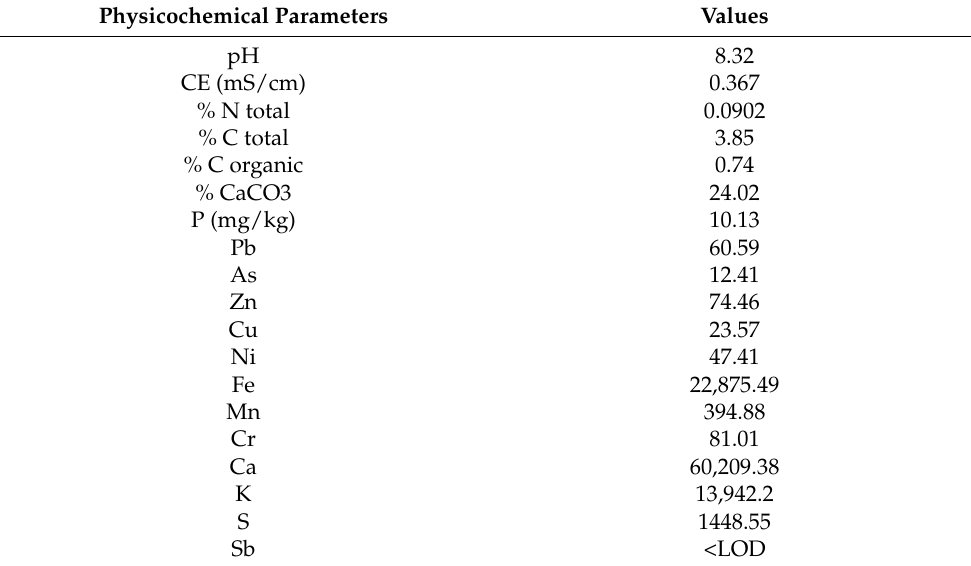
Table 1. Physicochemical characterization of the